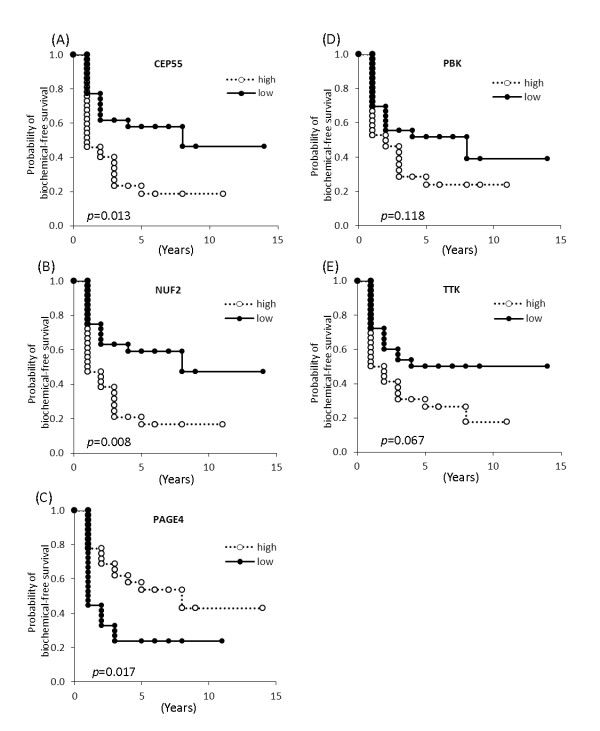
Kaplan-Meier analyses. Kaplan-Meier curves showing biochemical recurrence-free survival against time after radical prostatectomy stratified by the mRNA expression of (A) CEP55, (B) NUF2, (C) PAGE4, (D) PBK, and (E) TTK (high versus low groups dichotomized by median value).